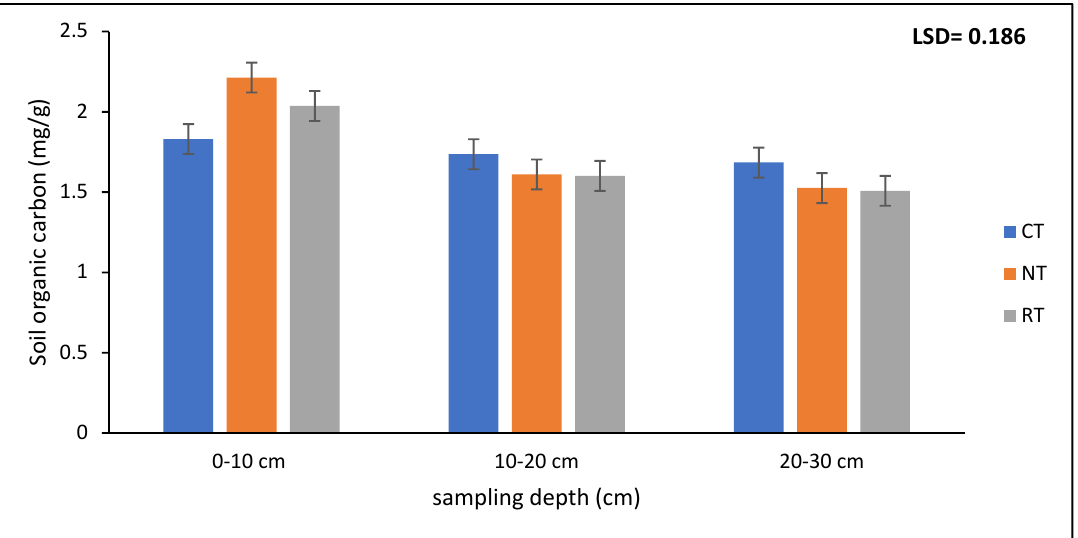
Figure 7. Soil organic carbon (SOC) at three different sampling depths (0–10, 10–20, 20–30 cm) after 17 years of trial establishment. CT = conventional tillage, RT = rotational tillage, NT = no-till.